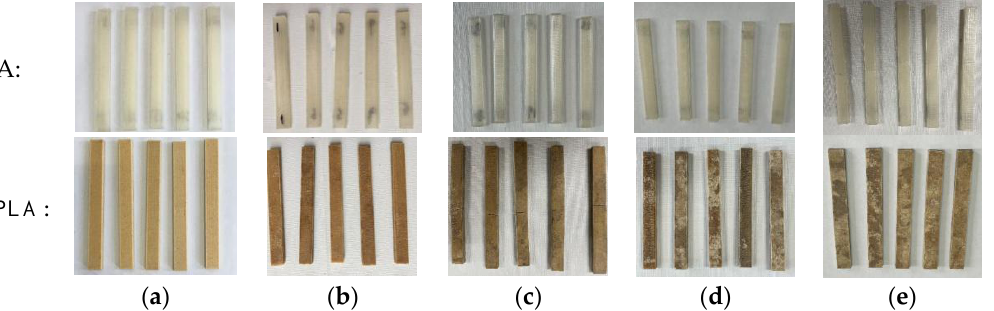
Figure 4. Photographs of PLA and ARP/PLA samples after different days of soil burial: ( a ) 0; ( b ) 30; ( c ) 60; ( d ) 90; ( e ) 180.